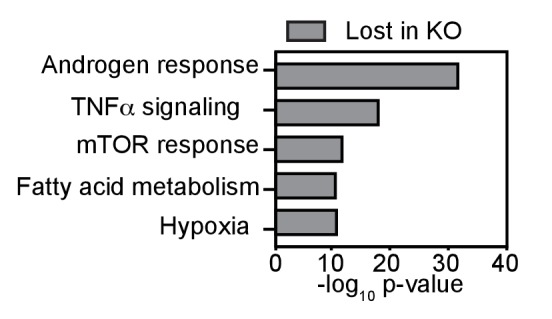
Top five HALLMARK terms (GSEA) associated with direct AR-target genes lost in Bag-1L KO compared to control cells.Direct AR-target genes were defined as genes with DHT-induced differential expression (p≤0.05, fold change ≥1.5) that harbor a DHT-responsive AR binding site within 50 kb of the TSS of said gene.